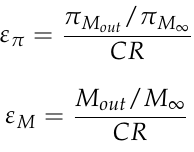
Table 4. Aerodynamic characteristics under a wide range of inflow speed conditions.